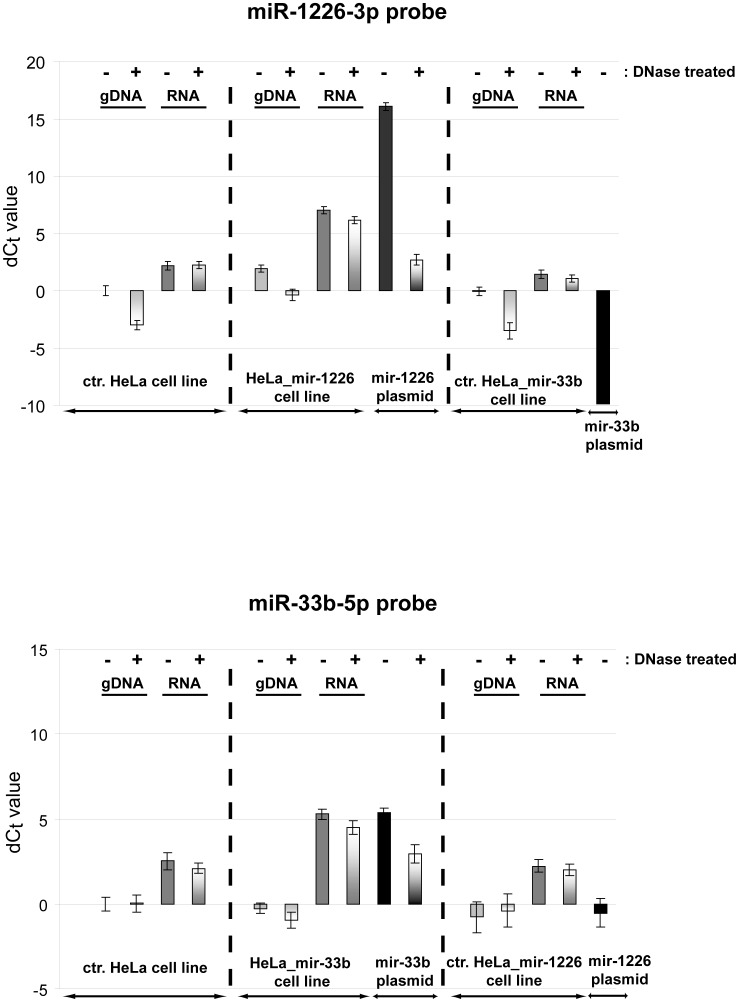
The effect of DNA contamination on mature miRNA measurements.Mature miR-1226-3p and miR-33b-5p detection were tested on the indicated samples, with or without DNase treatment. On the y-axis, dCt value is represented, calculated as the Ct difference between the examined samples and the gDNA of control HeLa cell line (Ct = 33,8 for miR-1226-3p and Ct = 34,9 for miR-33b-5p experiments). Signal was not detected up to 40 reaction cycles for the mir-33b plasmid control by the miR-1226-3p assays. One Ct difference represents about 2× higher detected mature miRNA level. The effect of DNA is probe specific and plasmid DNAs have more pronounced effect on the measurements than gDNA contaminations. Experiments were carried out with three replicates at least twice, one representative experiment is shown. Error bars represent standard deviations.